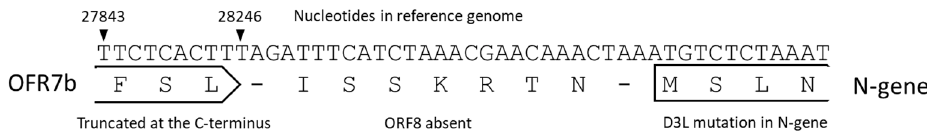
Figure 2. ORF8 deletion (Delta 394) observed in the cluster of samples from Oldham, UK.